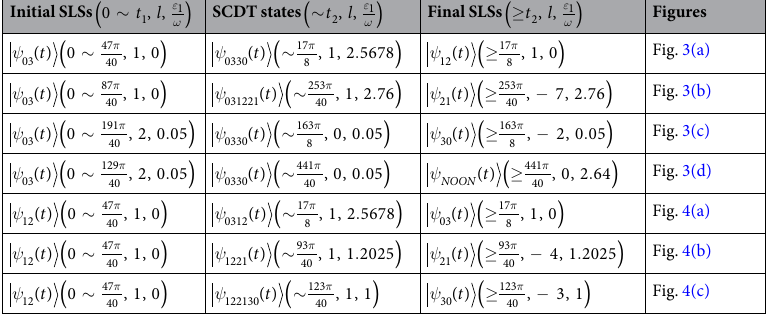
Table 1. Several control proposals of quantum transitions between QDSLSs for some initially fixed parameter sets ( n , m , Ω i ).